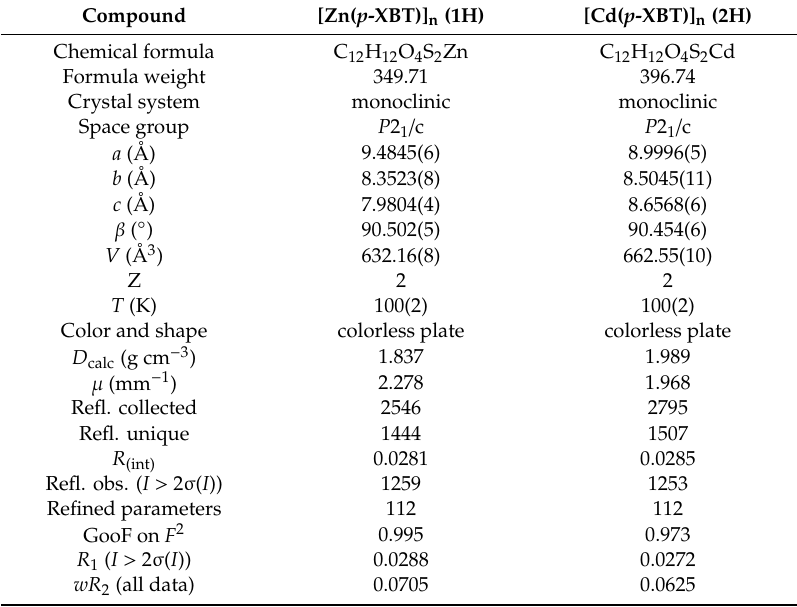
Table 1. Summary of crystallographic data and refinement details for 1H and 2H